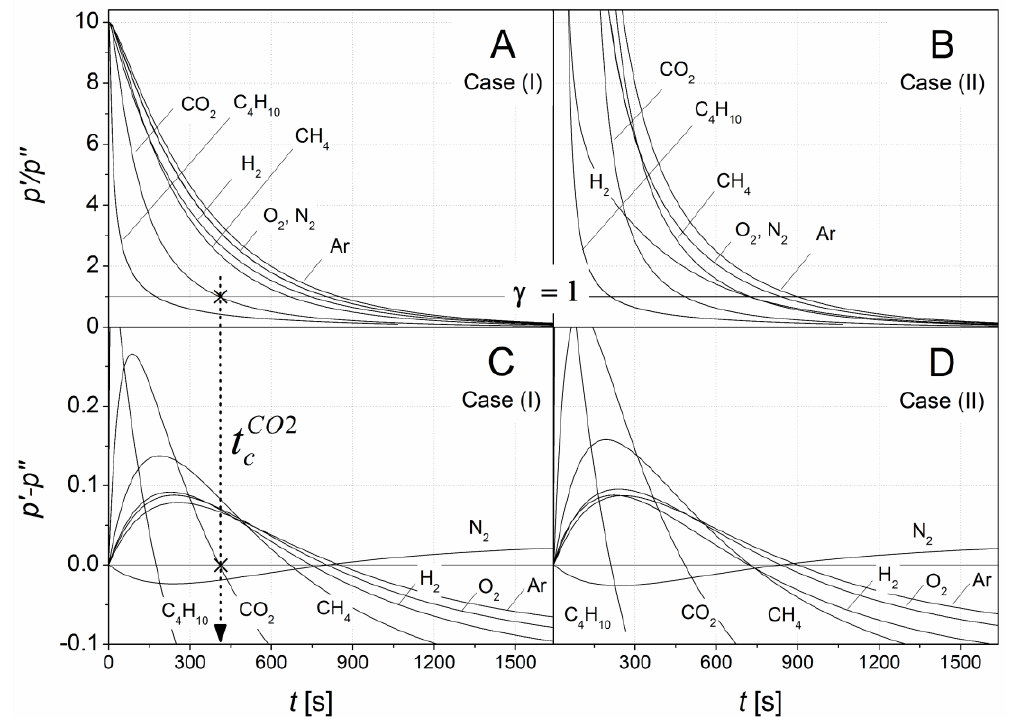
t , for identifying CO 2 c